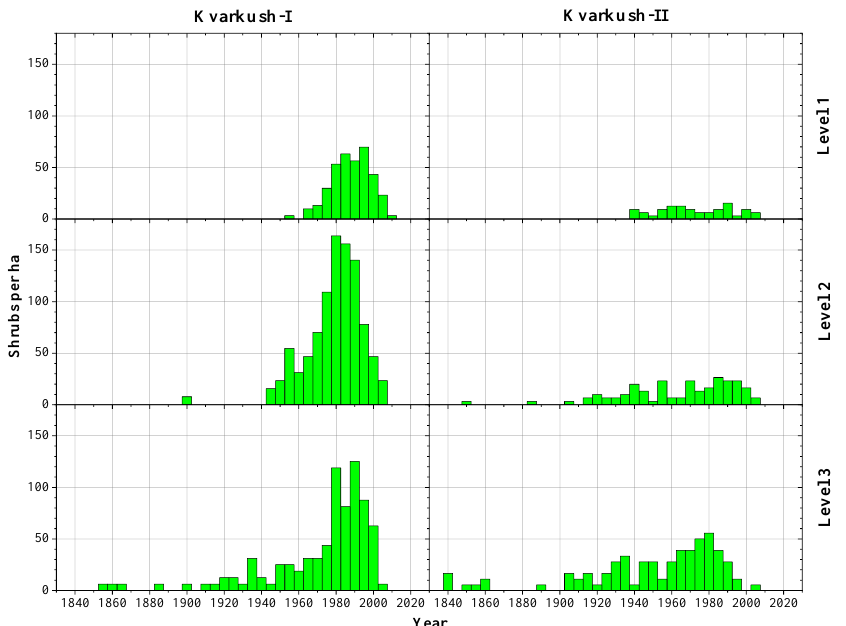
Figure 6. Age structures of J. sibirica in Kvarkush, Northern Urals. Levels 1, 2, and 3 correspond to the high, mid, and low elevations, respectively.